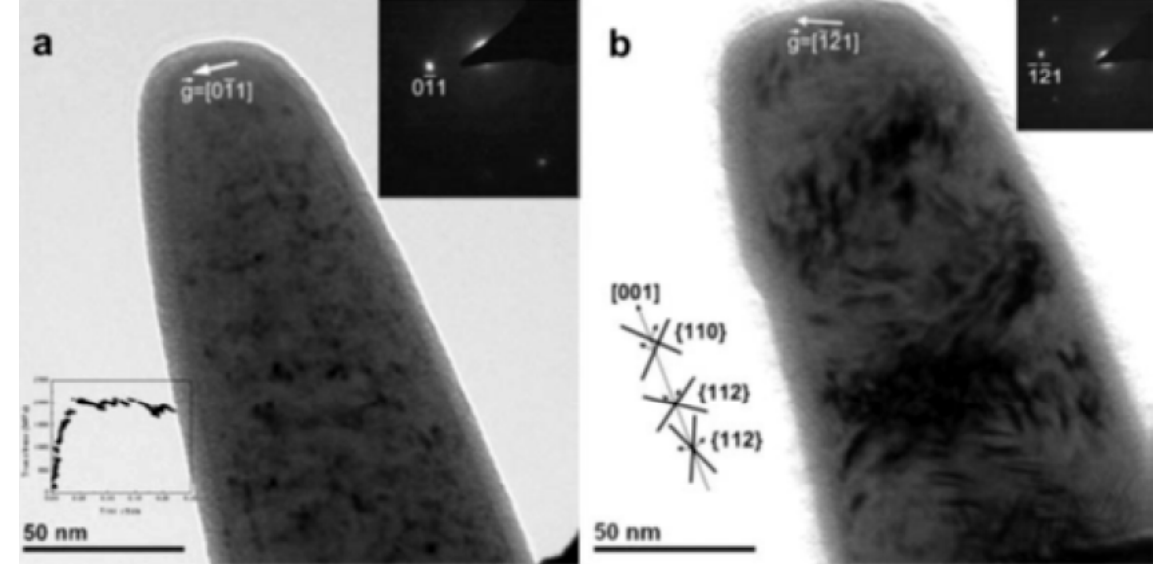
Fig. 27. Bright-field TEM images and corresponding diffraction patterns of 100 nm Nb nanopillar (a) before and (b) after compression, in which the true stress–strain curve and representative slip planes are inserted. Reprinted with permission from Kim JY, Jang DC, Greer JR. 2009. Insight into the deformation behavior of niobium single crystals under uniaxial compression and tension at the nanoscale. Scripta Materialia